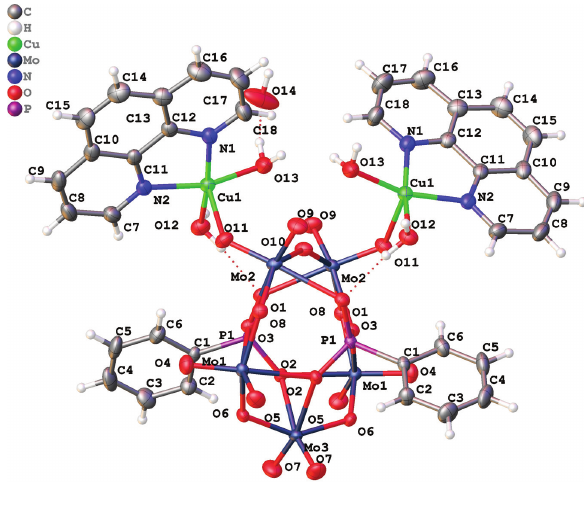
Table 1: Data collection and handling.